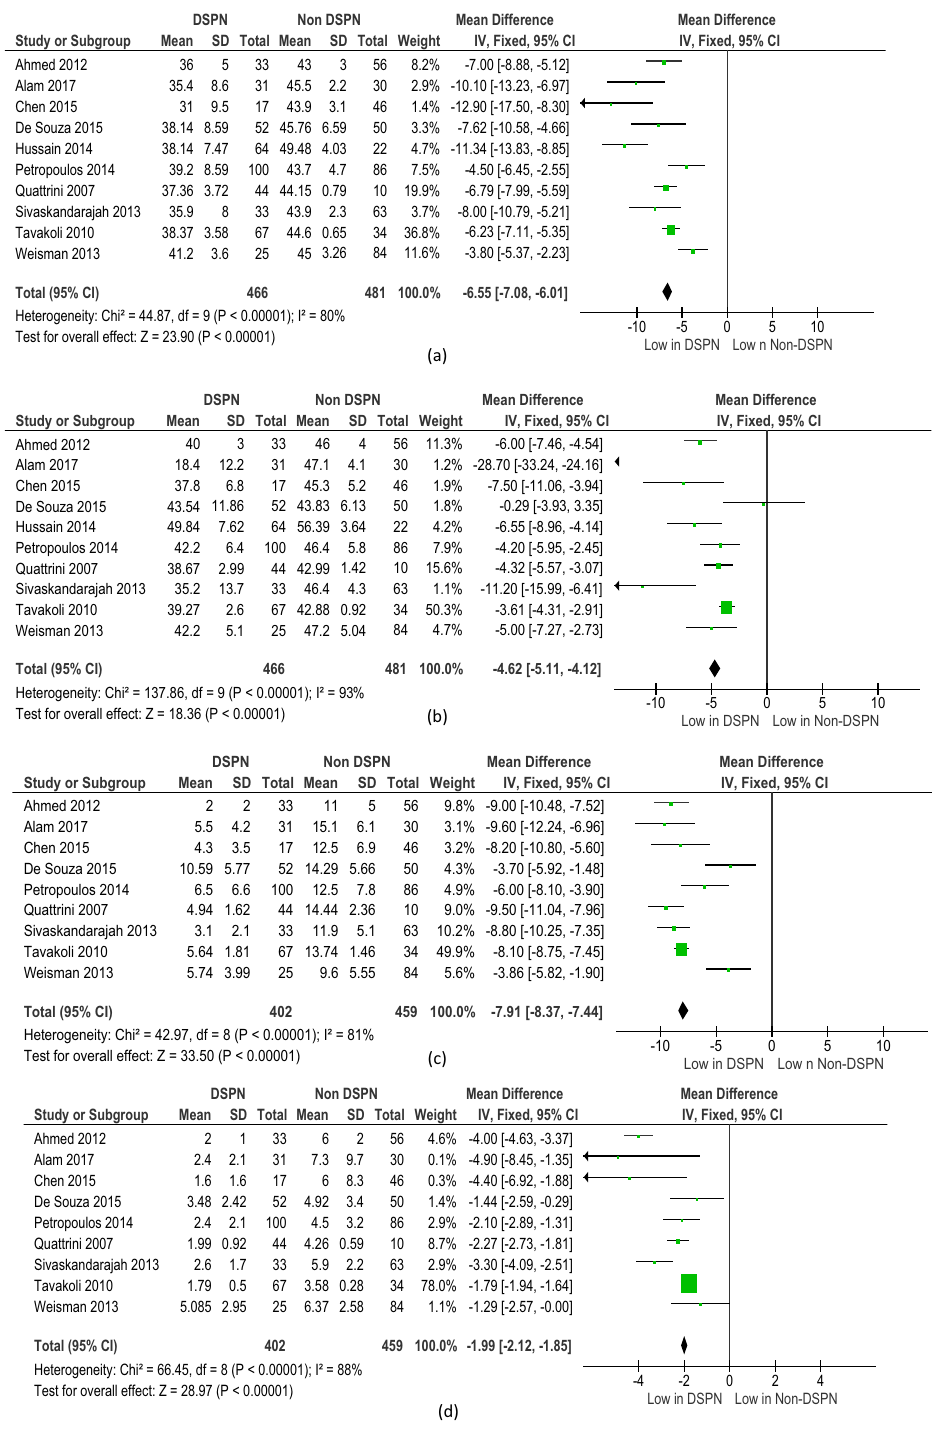
Figure 2. Forest plots for NCS diagnosis parameters comparing DSPN and Non-DSPN groups ( a ) PMNCV, ( b ) SSNCV, ( c ) SSNamp, ( d )